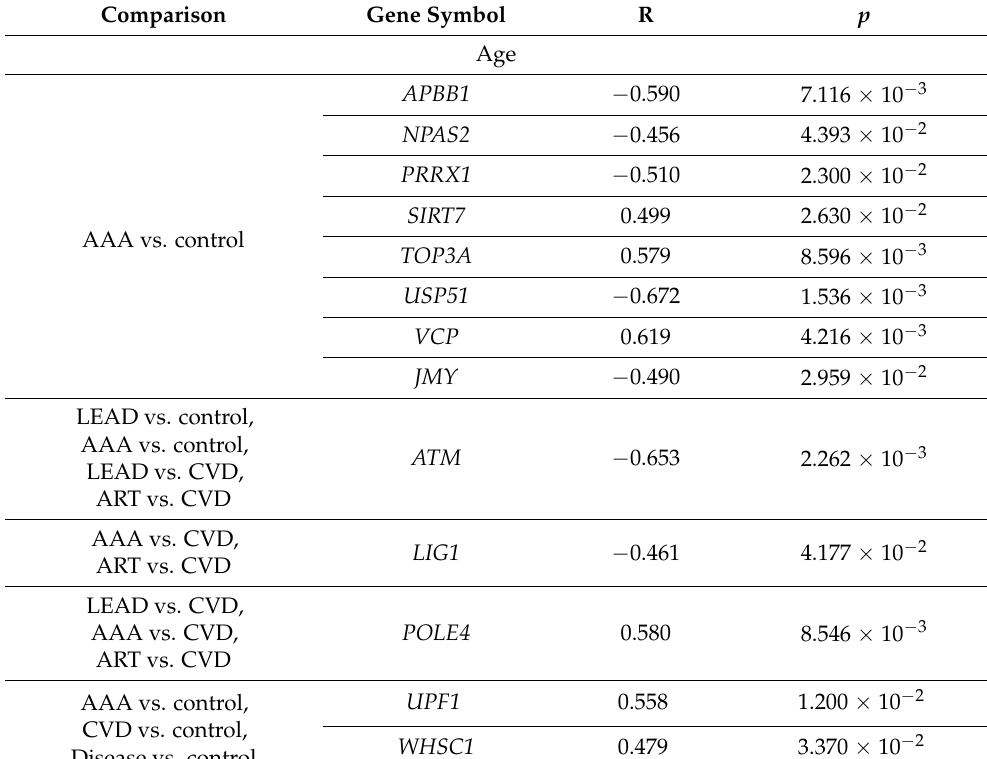
Table 3. Correlation analysis between characteristics of studied groups: age and body mass index (BMI) and expression of genes selected from comparisons performed. The table presents genes correlated with statistical significance p < 0.05 (adjusted by Benjamini–Hochberg